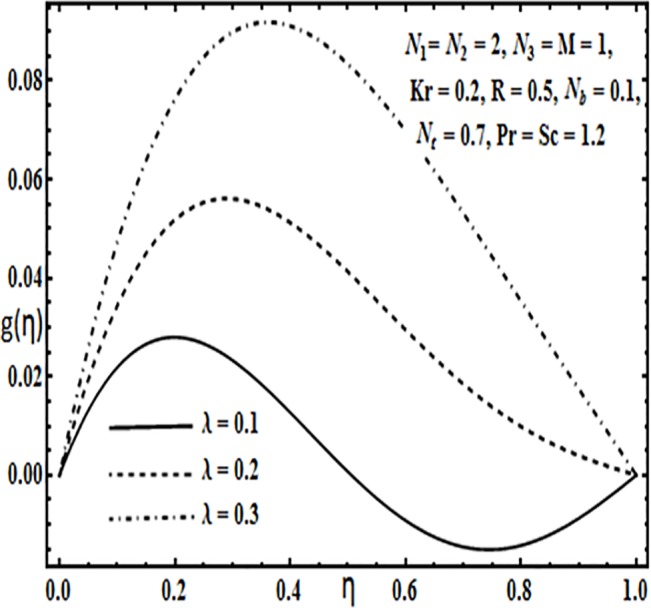
Effect of λ on g(η).